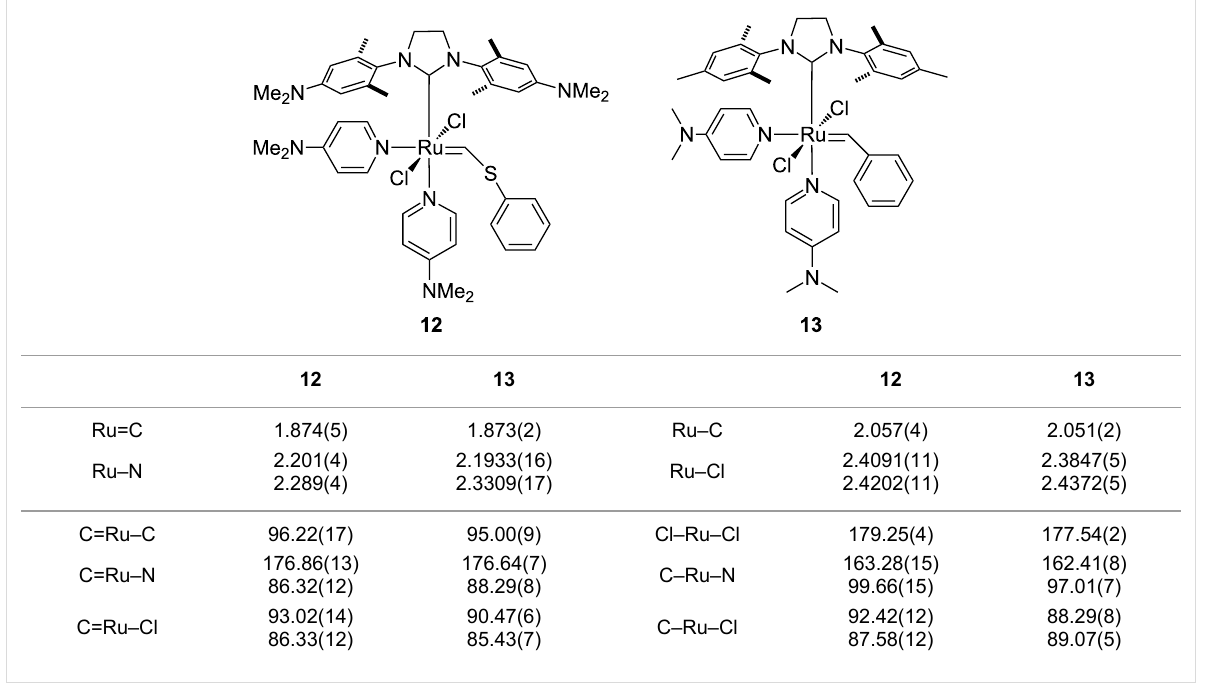
Table 1: Selected bond lengths (Å) and angles (°) for complexes 12 and 13 [46].